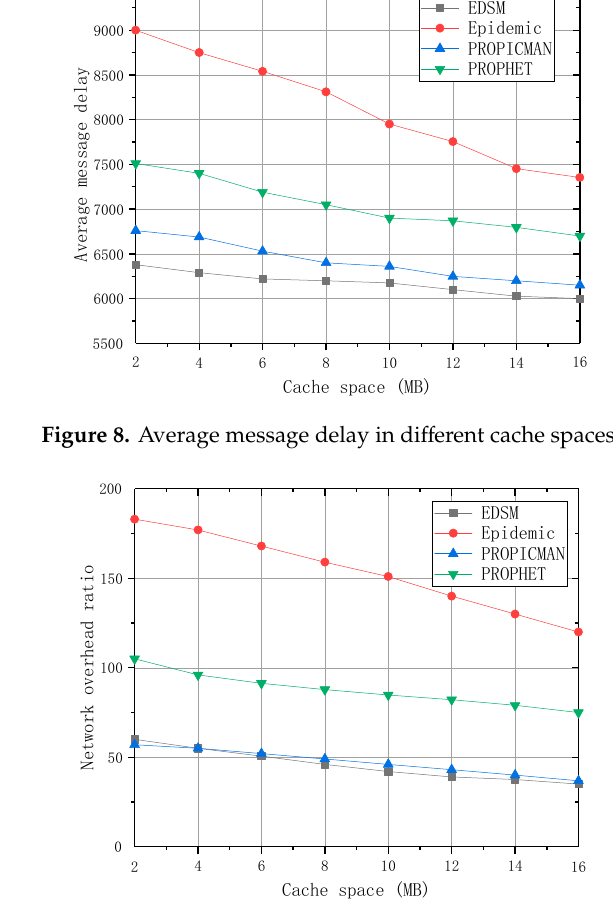
Figure 9. Network overhead ratio in different cache spaces.